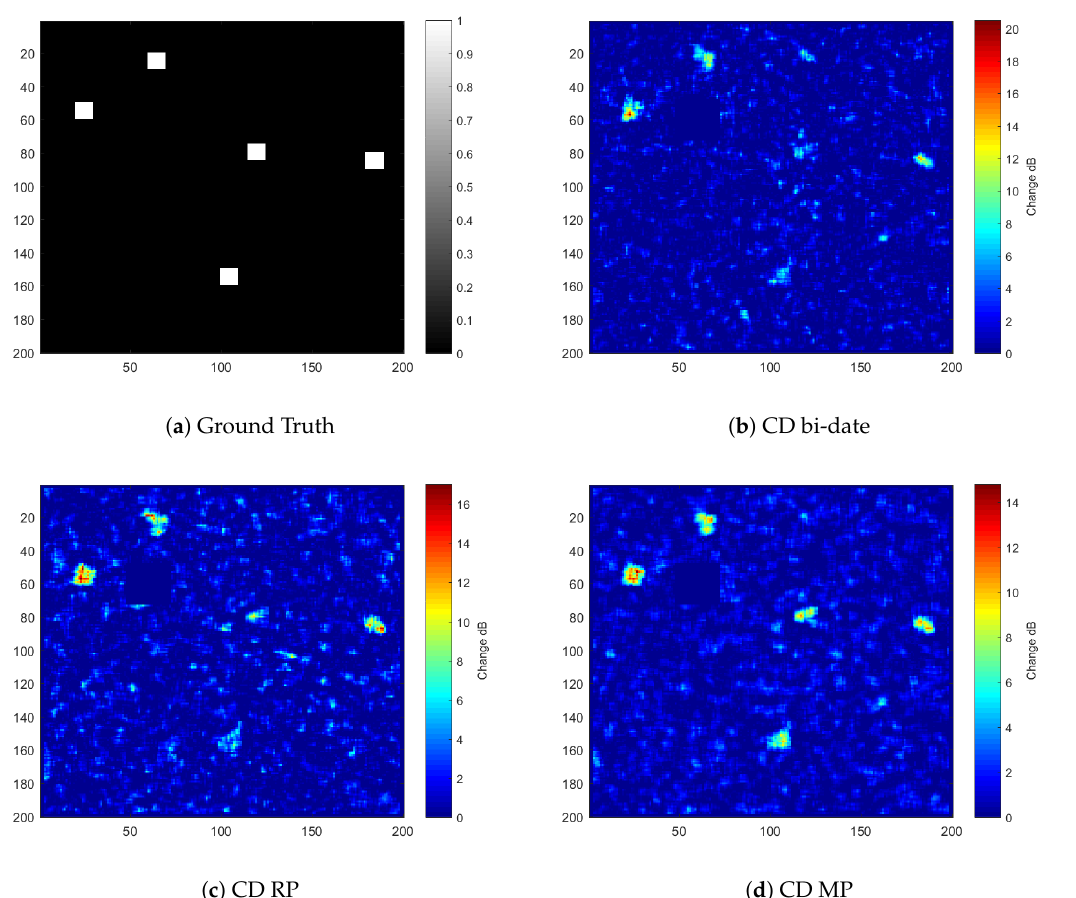
Figure 7. Example of the CD ground truth and change map for SNR = 3